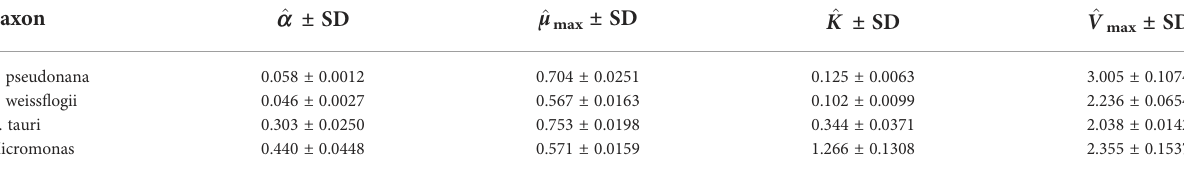
A ˆ indicates the value was estimated by maximum